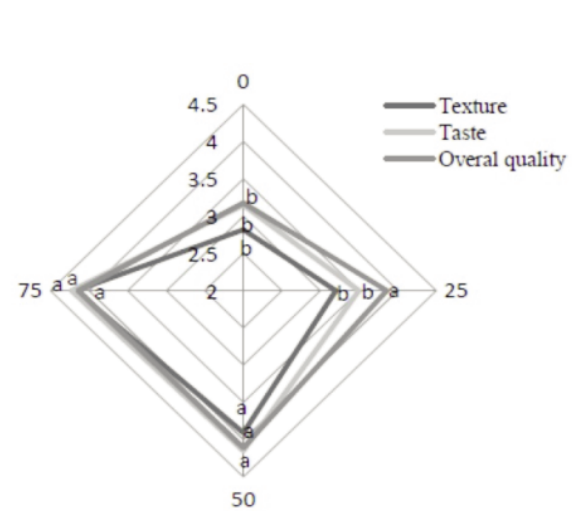
Fig. 6 ­ Sensory evaluation in figs ( Ficus carica L.) ‘Siyah’ fruit treated with Aloe vera gel (0, 25, 50 and 75%) after tran­ sferring from 15 days in cold storage to the ambient tem­